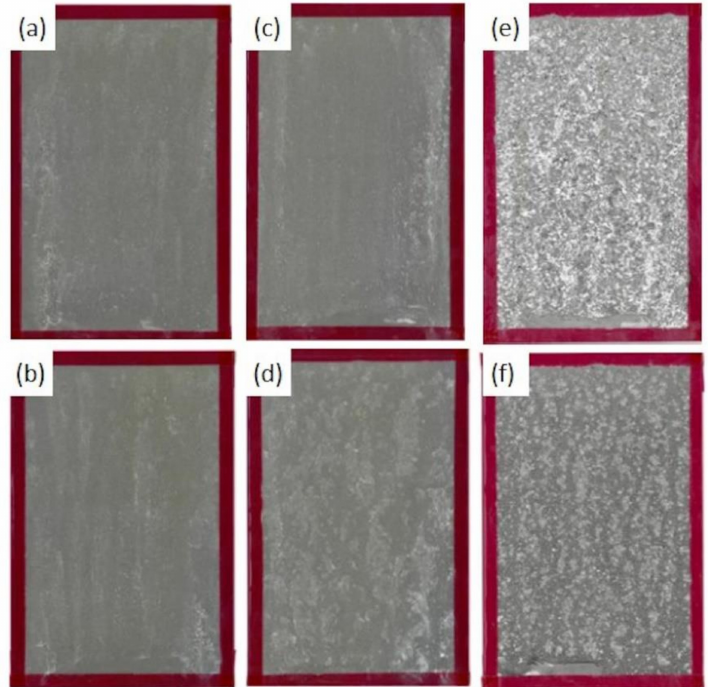
Figure 9. Samples after 72 h of NSS test: ( a ) 2-Ce-10 and ( b ) 7-Ce-10. Samples after 96 h of SST: ( c ) 2-Ce-10, ( d ) 7-Ce-10, ( e ) 2024-bare, and ( f )